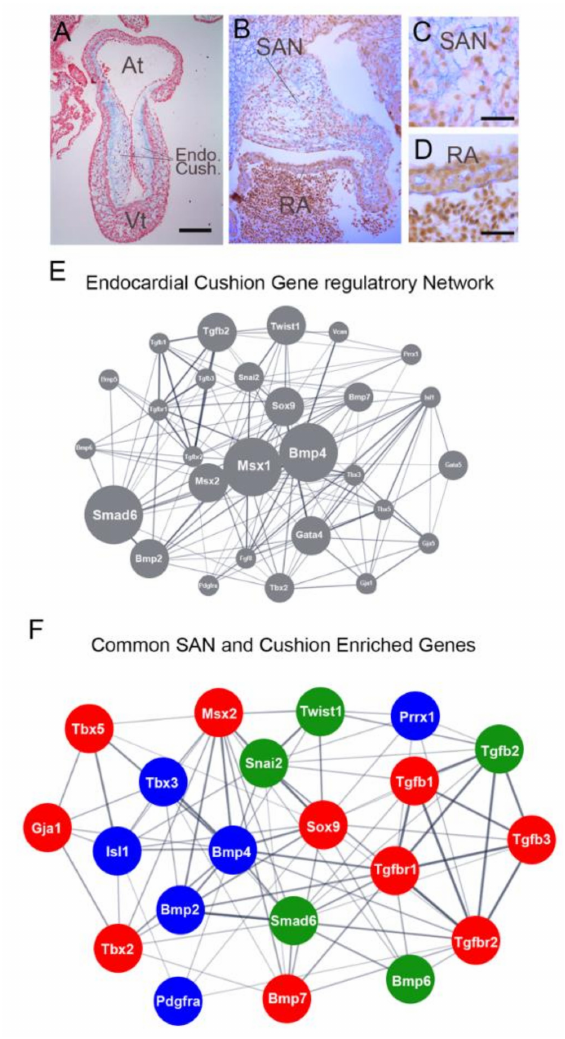
Figure 4. Genetic pathways active during sinoatrial node remodeling. ( A ) Sagittal section through an HH stage 19 chick heart stained with alcian blue (blue) which labels HA and nuclear fast red (red). Endocardial cushions are indicated. Scale bare—500 mm. ( B ) Section through the remodeling sinoatrial node of a chick embryo at HH stage 29. Sinoatrial node (SAN) and right atrium (RA are indicated). ( C , D ) Higher magnification images from ( B ). Scale Bars—50 mm. ( E ) Genes list was generated by comparing the Gene Ontology (GO) term Endocardial Cushion Development (0003197) with the gene regulatory networks published by DeLaughter et al. [149] and enriched genes from Schroeder et al. [150] and Singh et al. [151]. Node size reflects the number of data sets in which the indicated gene is present. Line thickness denotes confidence of potential interaction between genes [152]. ( F ) Comparison of genes identified as upregulated in the sinoatrial node based on sequencing studies from Vedantham et al., Bressan et al., and Van Eif et al. [104,128,129] Genes with greater than two-fold enrichment over atrial myocardium in all three data sets were compared to the gene-regulatory network for cushion formation in ( D ). Genes in blue nodes were enriched in all three RNA sequencing data sets, green nodes were present in two data sets, red nodes were detected in one data